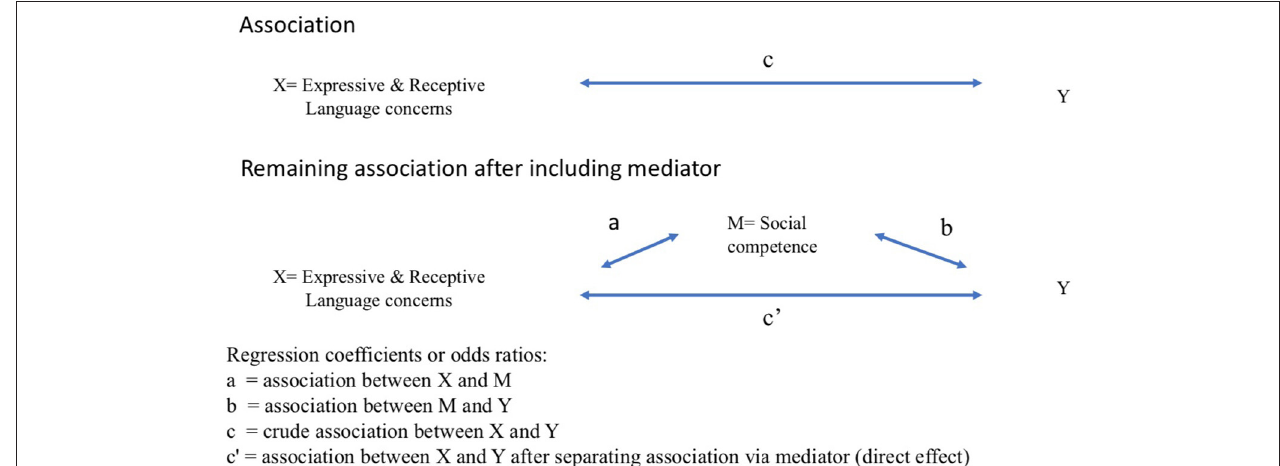
FIGURE 2 | Theoretical figure to explain analysis of mediation.